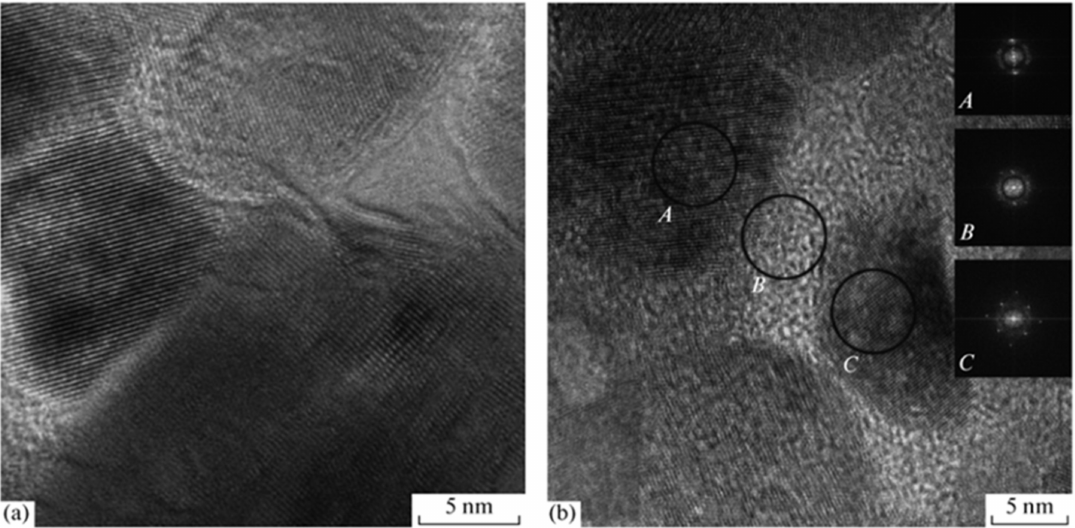
Figure 41. BF-TEM micrographs of doped ZnO thin films with ( a ) 10 at% Mn ZnO grains and ( b ) 15 at% Mn ZnO grains, surrounded by amorphous layers. The insets in ( b ) show the fast Fourier transform patterns for crystalline and amorphous regions, A, B and C, respectively [289]. Figure 41 reprinted by permission from Springer Nature Customer Service Centre GmbH: Springer Nature, JETP Letters, Grain boundary layers in nanocrystalline ferromagnetic zinc oxide, Straumal, B.B.; Myatiev, A.A.; Straumal, P.B.; Mazilkin, A.A.; Protasova, S.G.; Goering, E.; Baretzky, B., M.H., Copyright ©